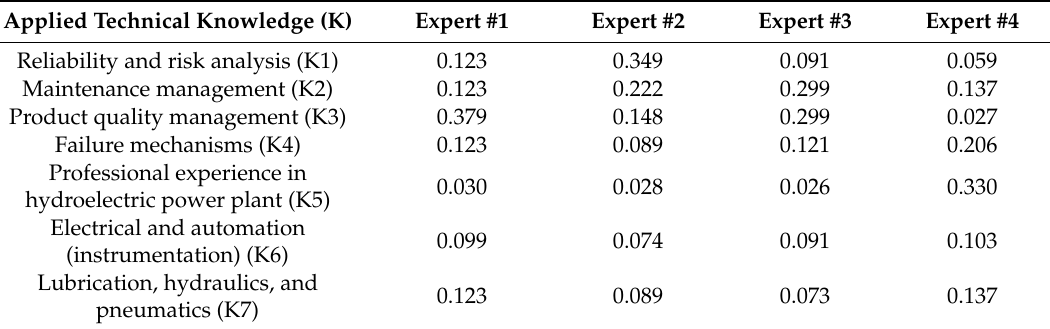
Table 7. Experts technical skills weights—Best-Worst Method (BWM)